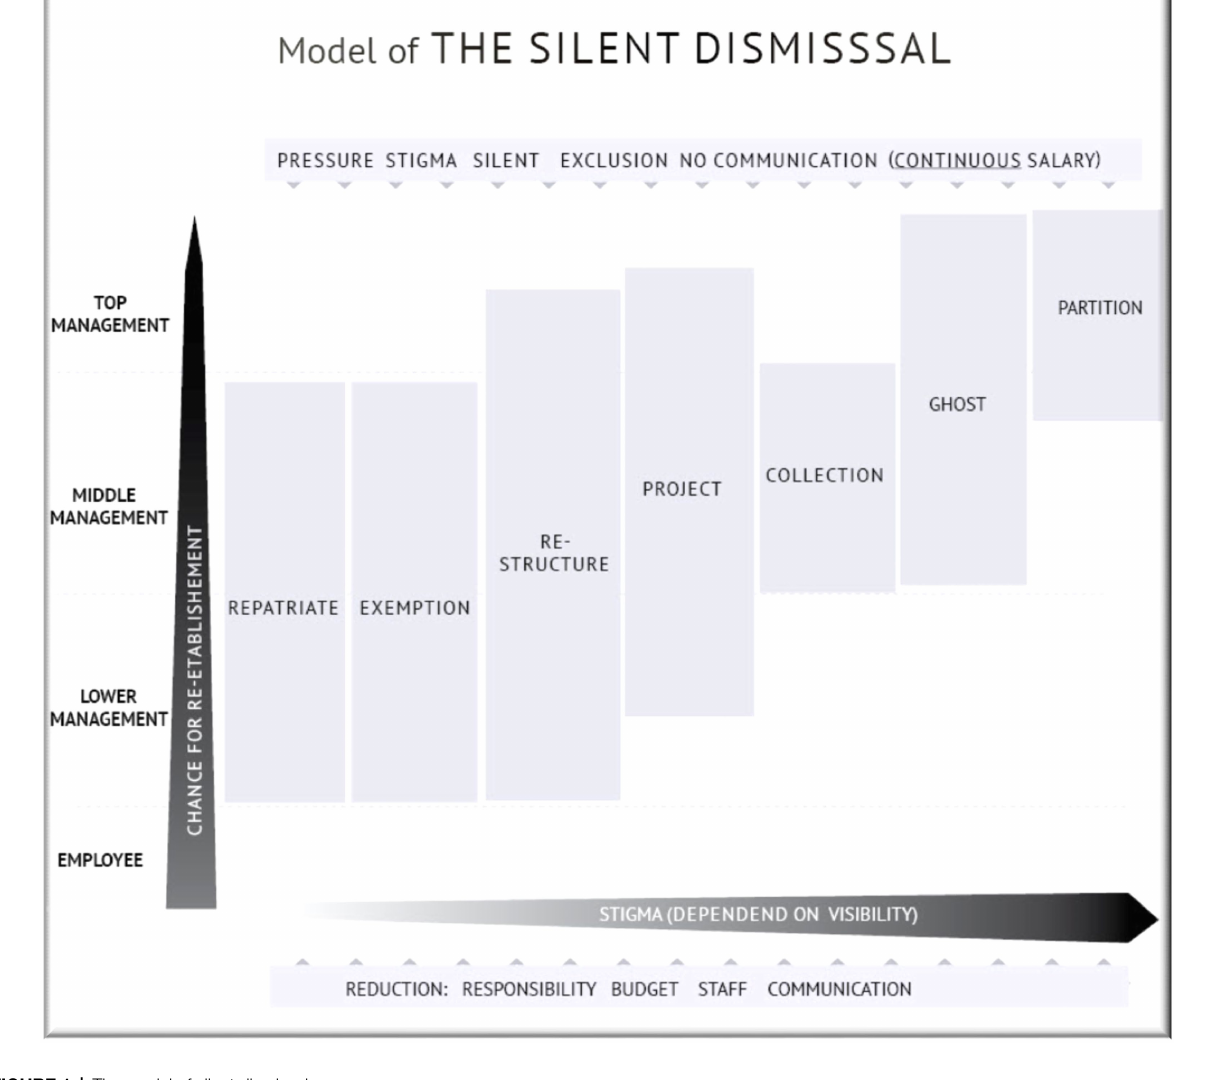
FIGURE 1 | The model of silent